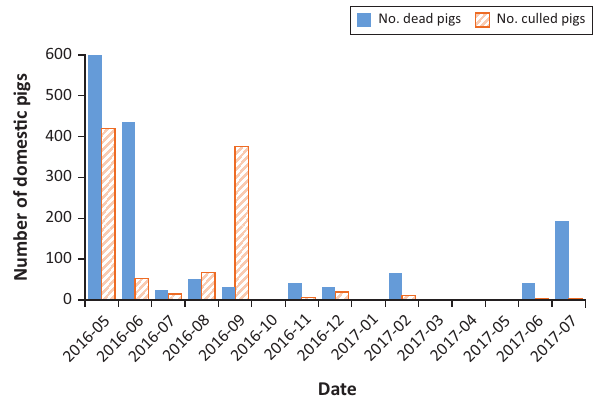
FIGURE 4: Number of domestic pigs affected per month during the 2016–2017 African swine fever